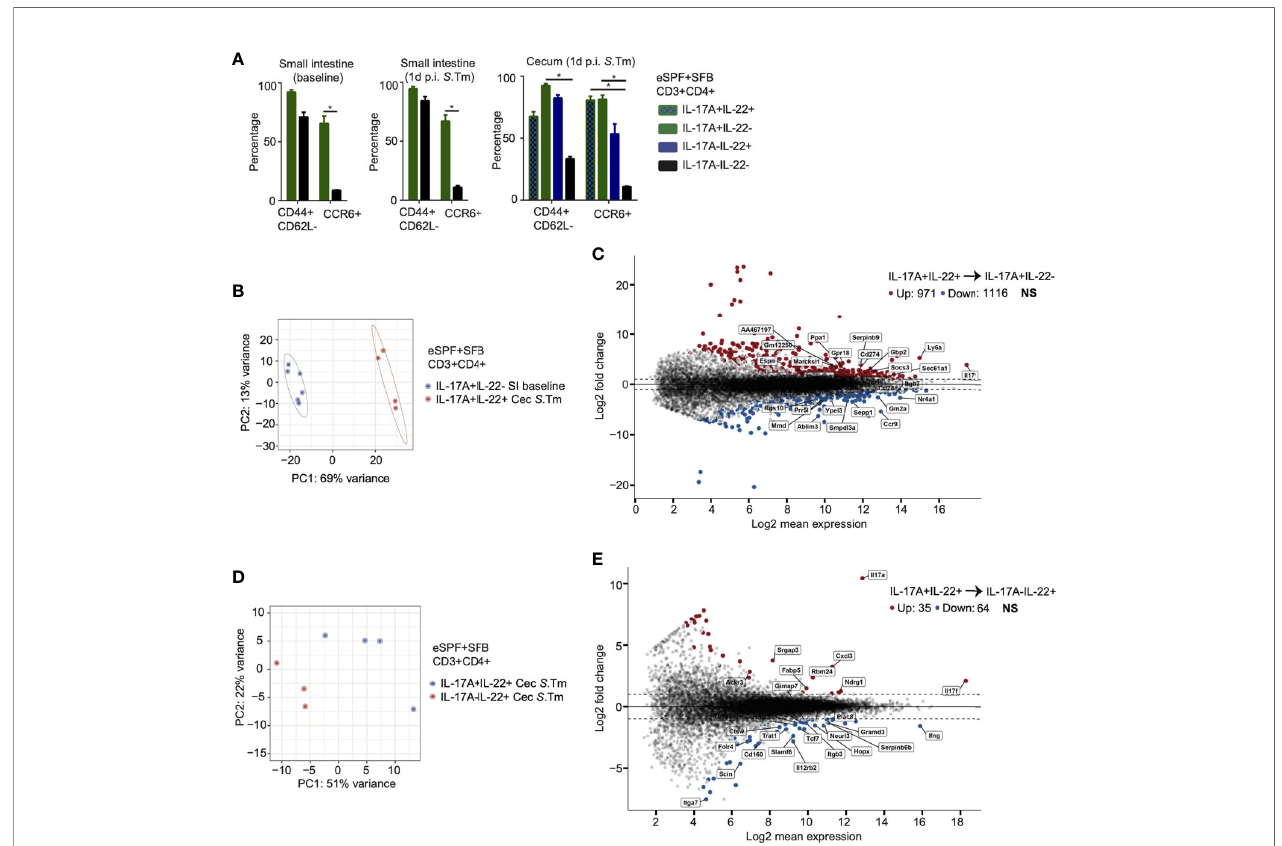
FIGURE 4 | Distinct properties of SFB modulated CD4 T cells. (A) CD3+CD4+ T cells from small intestinal and cecal LPL from eSPF+SFB mice during baseline and after 1d S . tm . infection were analyzed for the expression of CD44, CD62L, and CCR6 expression in IL-17A+ and/or IL-22+ and IL-17A-IL-22- cells in the absence of ex vivo restimulation. (B, C) RNA-seq analysis of sorted CD3+CD4+ IL-17A+IL-22- cells from small intestinal LPL during baseline and IL-17A+IL-22+ cells from cecal LPL 1d post S . tm . infection from mice colonized with eSPF+SFB microbiota. b -diversity analysis (B) and DEseq analysis (C) comparing signi fi cant